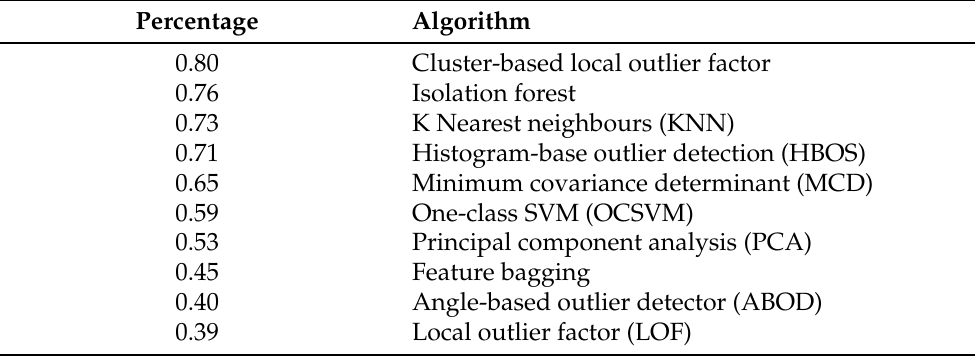
Table 3. Percentage that each outlier detection method was selected with by the unsupervised feature selection